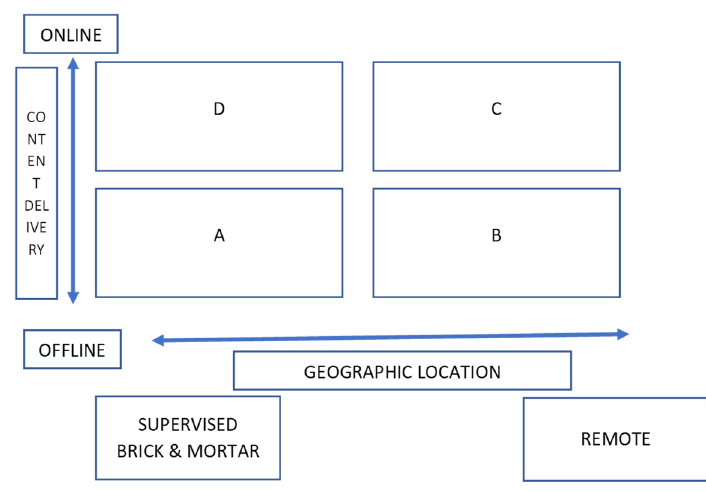
Figure 1. Blended learning chart.